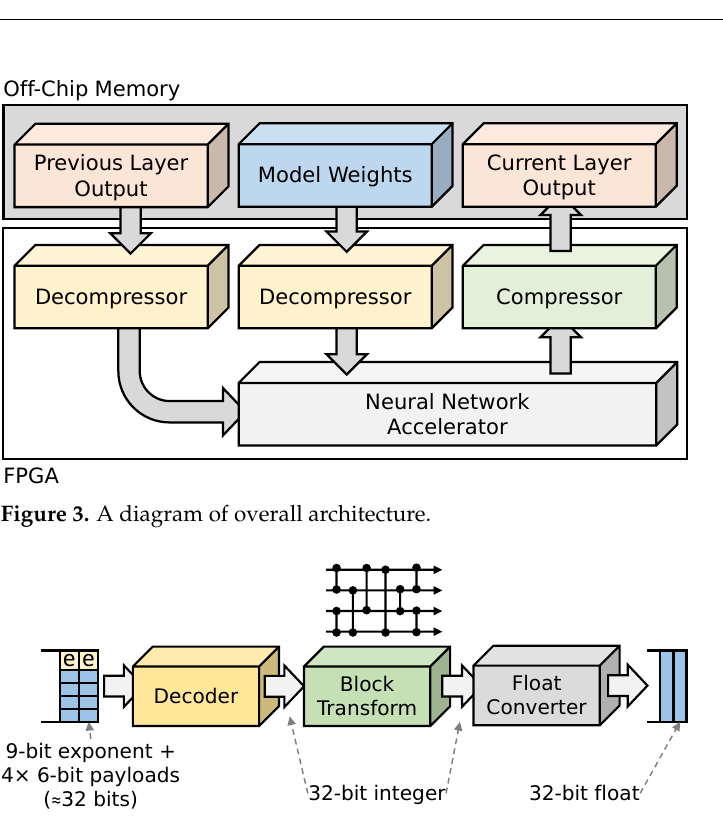
Figure 4. A ZFPe decompressor can always emit one float value every